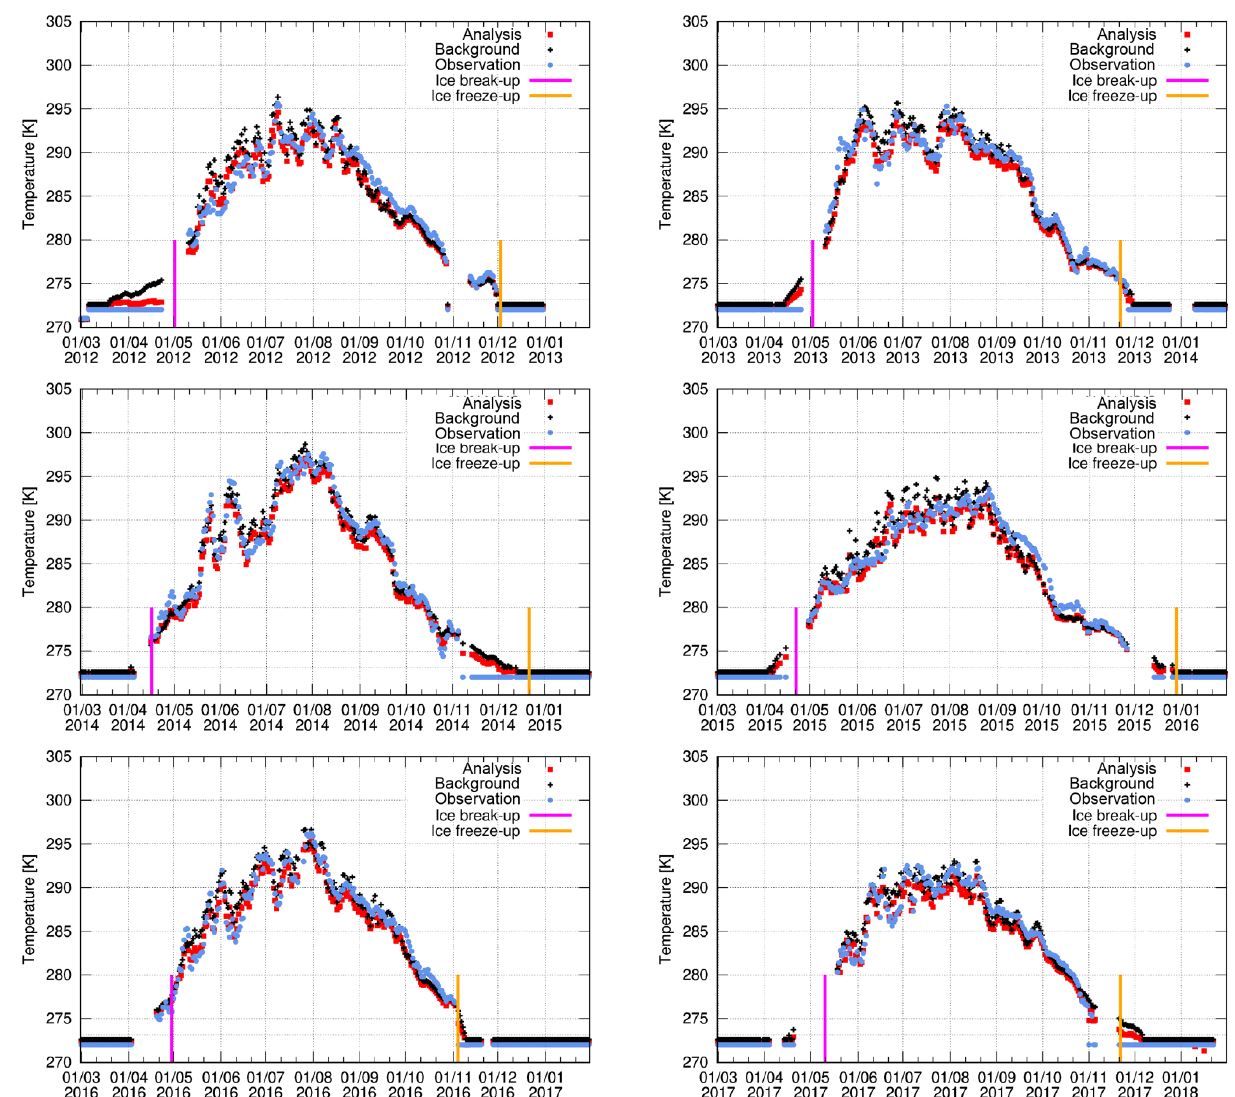
Figure 9. As for Fig. 8 but for lake Lappajärvi, 63.15 ◦ N, 23.67 ◦